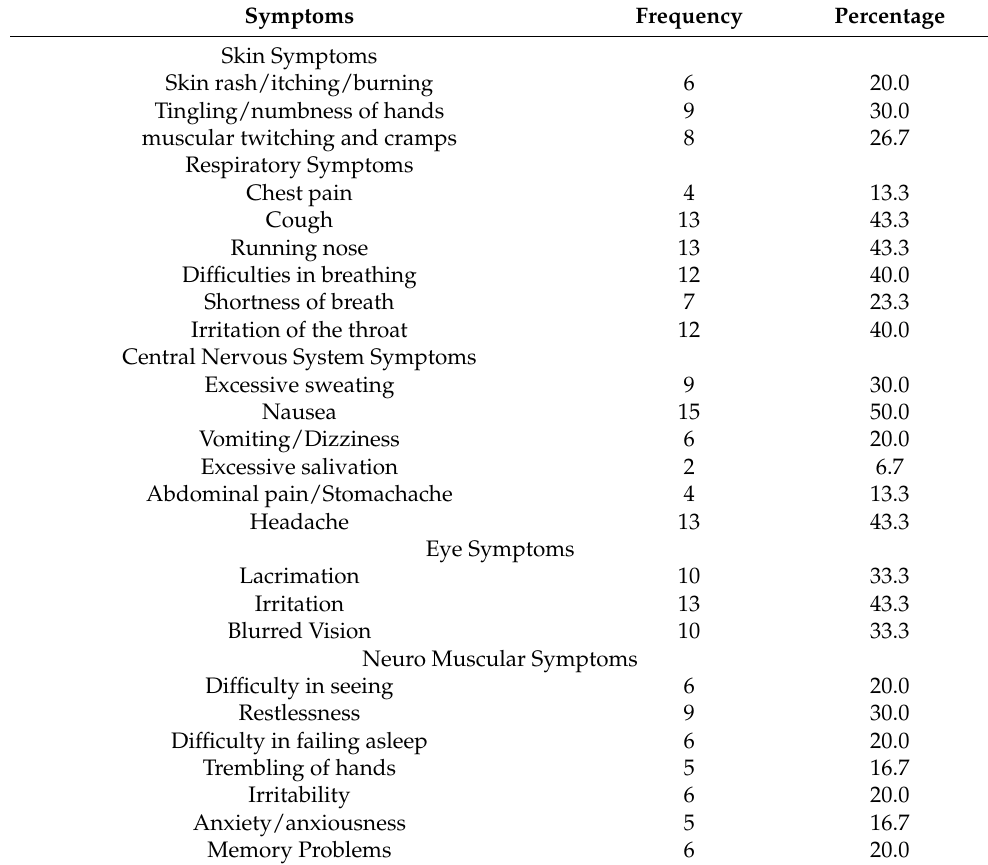
Table 6. Symptoms related to chemicals exposure ( n =